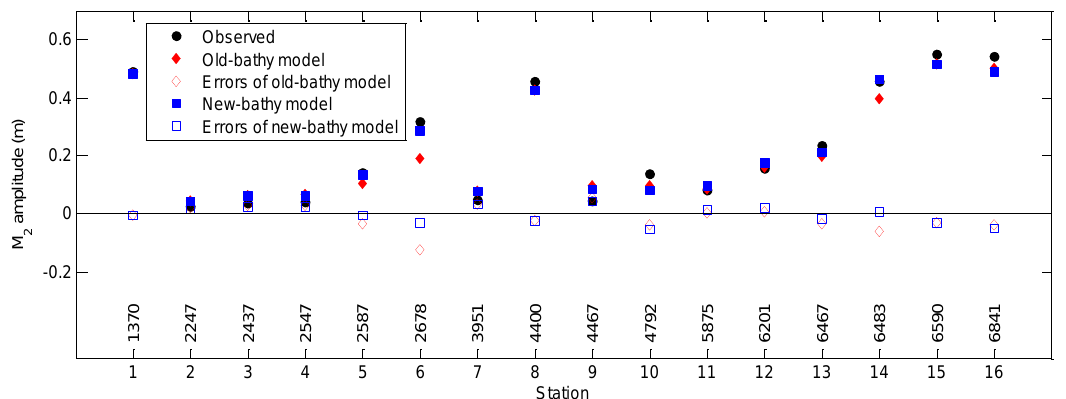
Figure 7. Comparison of the M 2 amplitude at 16 NOAA stations between the observations (black dots), the old-bathy model (red solid diamonds), and the new-bathy model (blue solid squares). The blank diamonds and squares indicate the model errors.